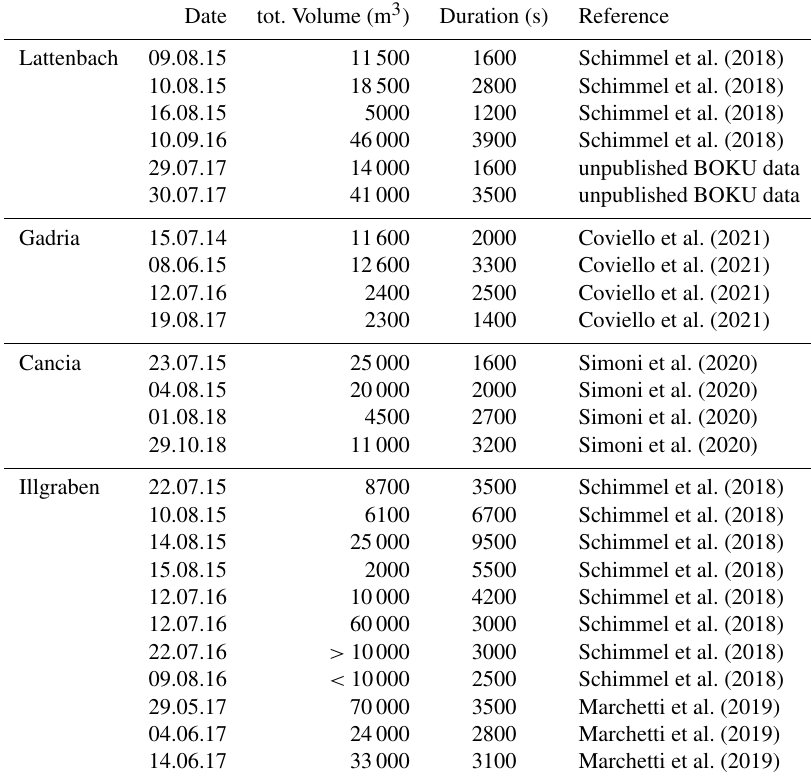
Table 2. List of event dates and volumes for all sites. Data gathered in Gadria, Cancia, and Lattenbach were used to retrieve the empirical Eq. (1) while data from Illgraben were used for validation; see Fig.